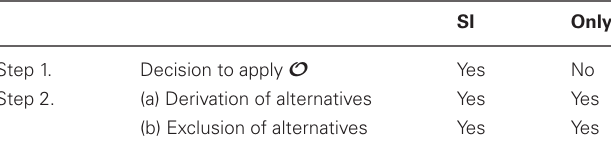
Table 1 | Description of the steps involved in the doubly bounded interpretation associated with scalar items (e.g., some ) and only